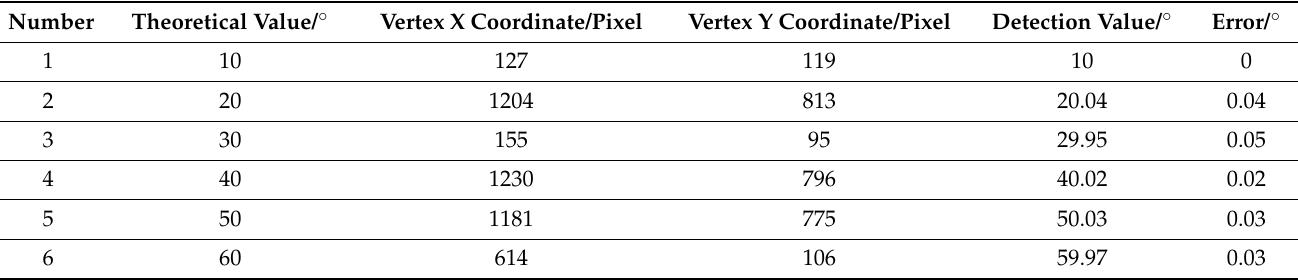
Table 2. Angle value detection results.